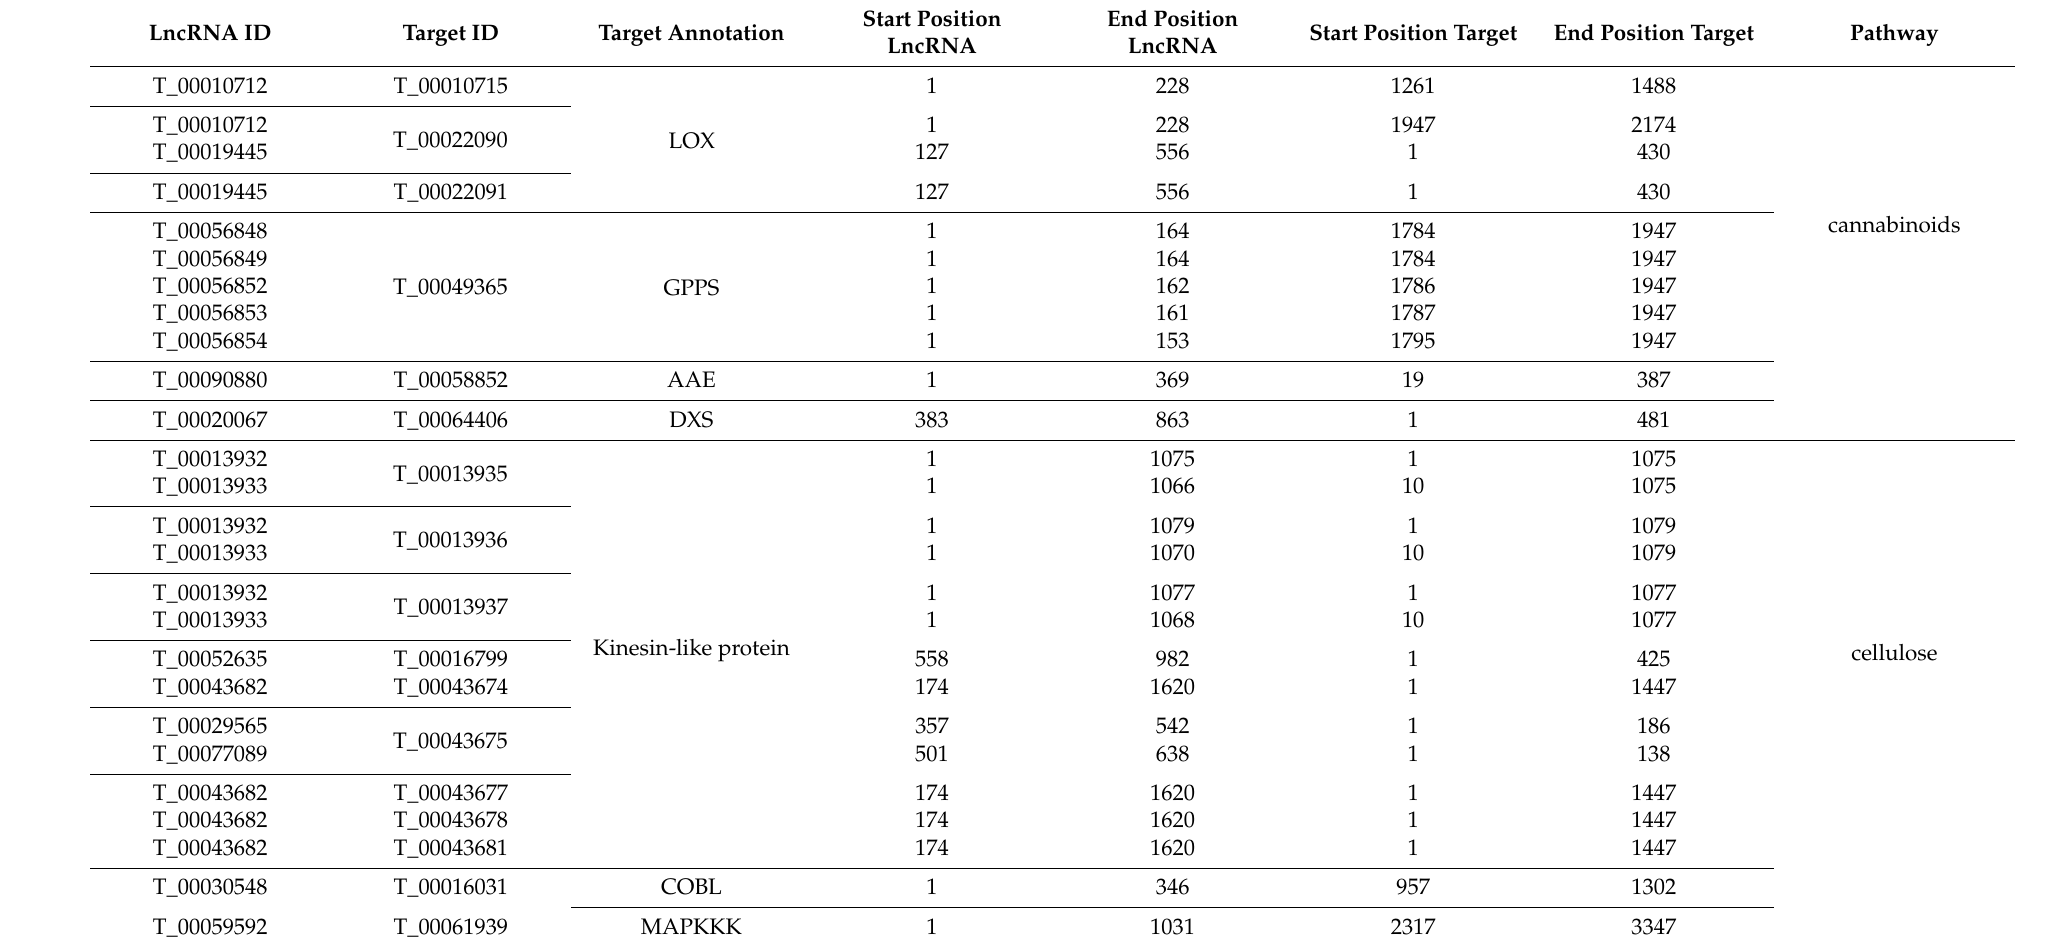
Table 2. LncRNAs targeted structural genes potentially involved in cannabinoids and cellulose